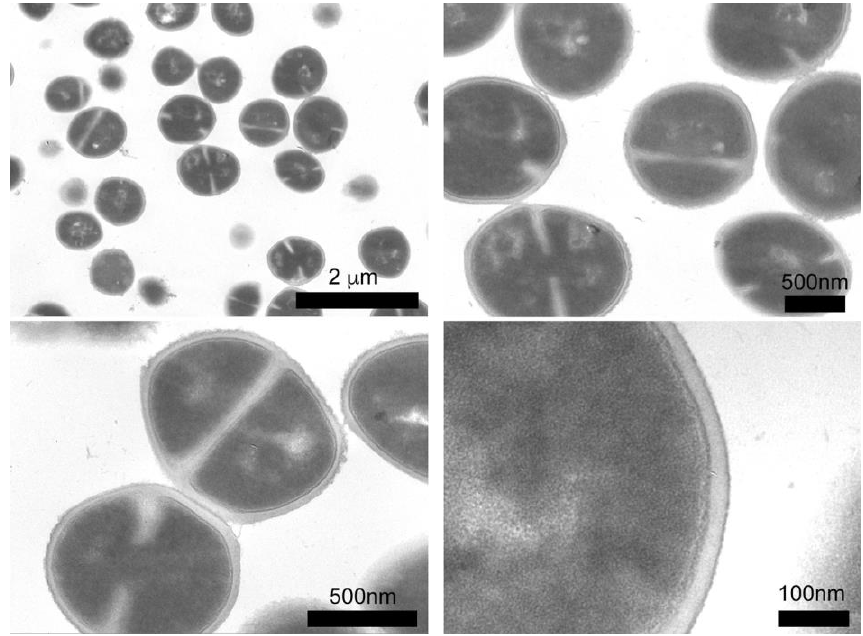
Figure 5. Cross sections of S. epidermidis (control sample) by TEM.